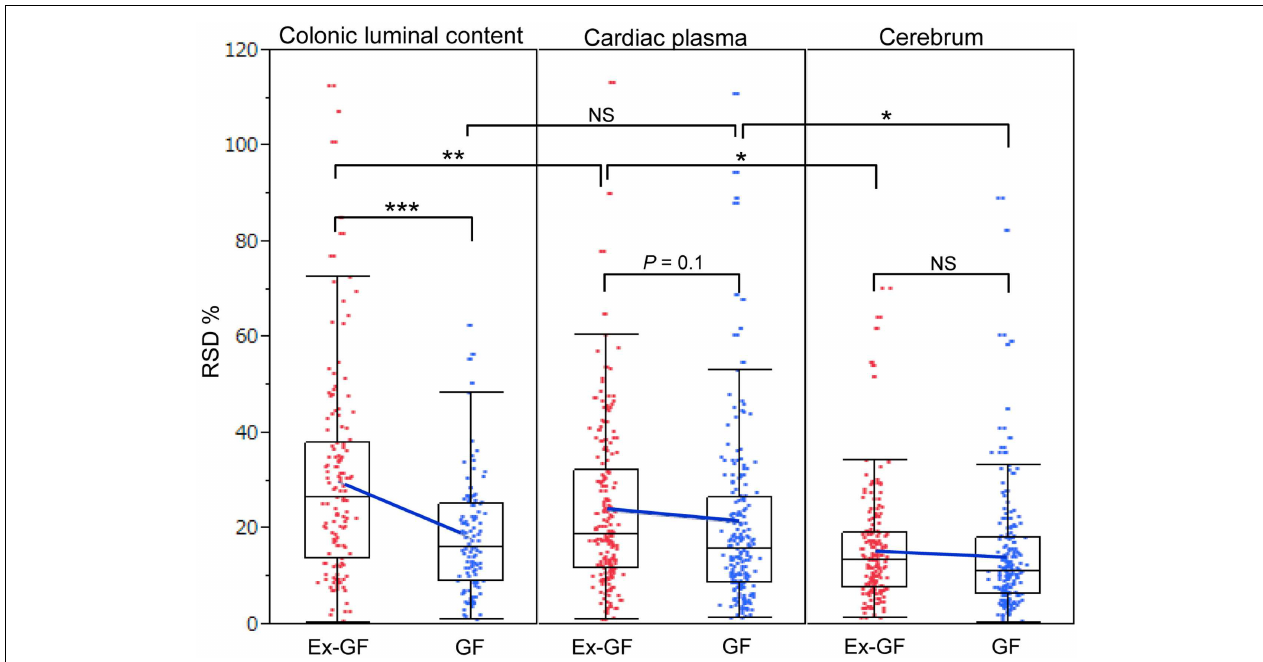
FIGURE 4 |The boxplot of RSD% of all metabolites detected from colonic luminal content, cardiac plasma, and the cerebrum . Blue cross bars represent the comparison of means between Ex-GF mice and GF mice. * p < 0.05, ** p < 0.01, *** p < 0.001 (GF vs.